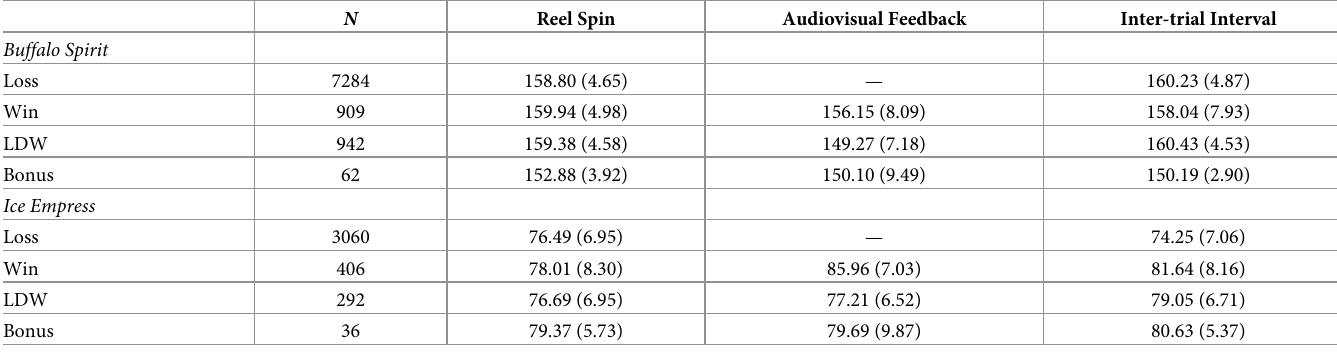
Table 2. Averaged slot machine screen luminance, full